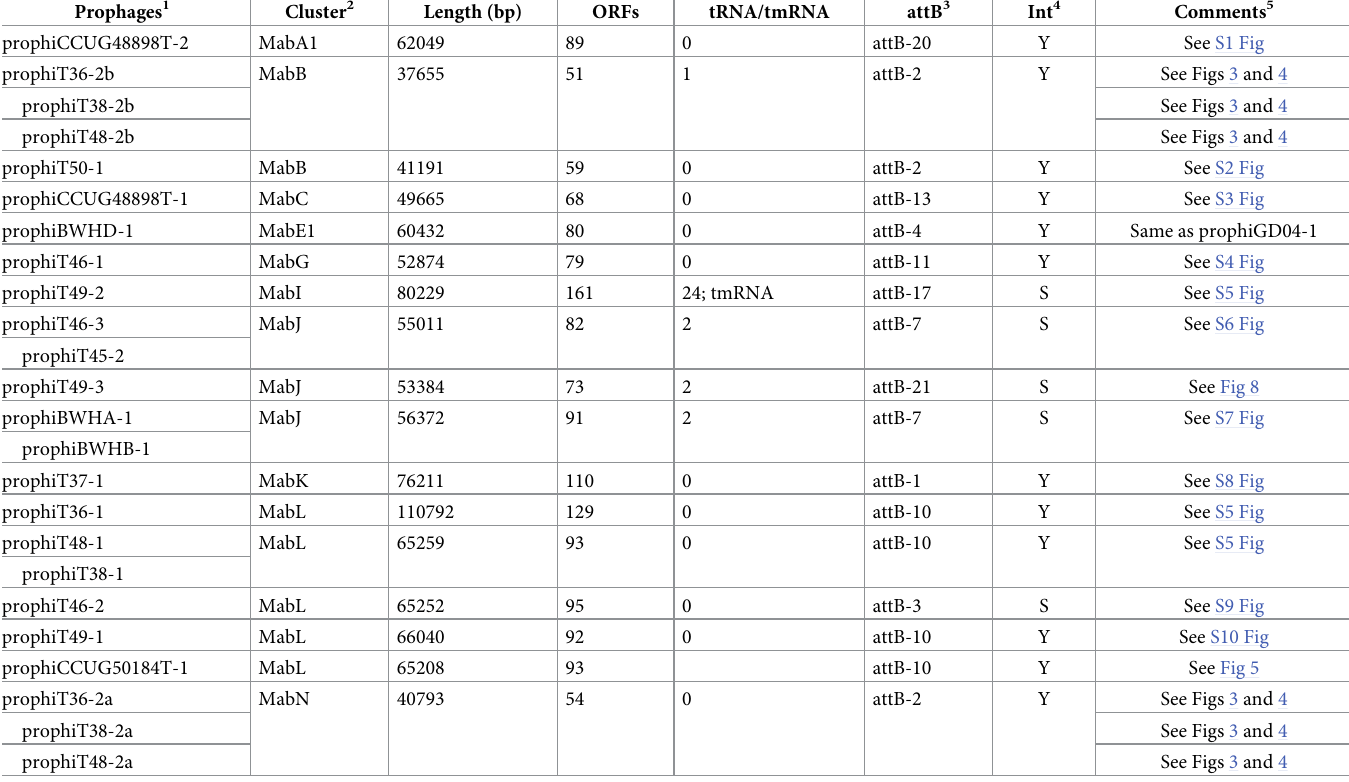
Table 2. M . abscessus